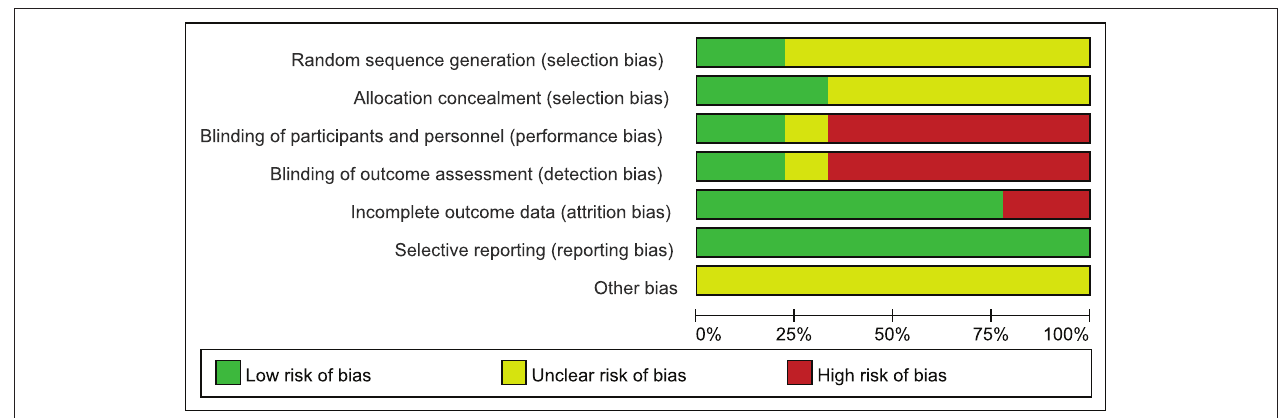
FIGURE 2 | Risk of bias graph of included